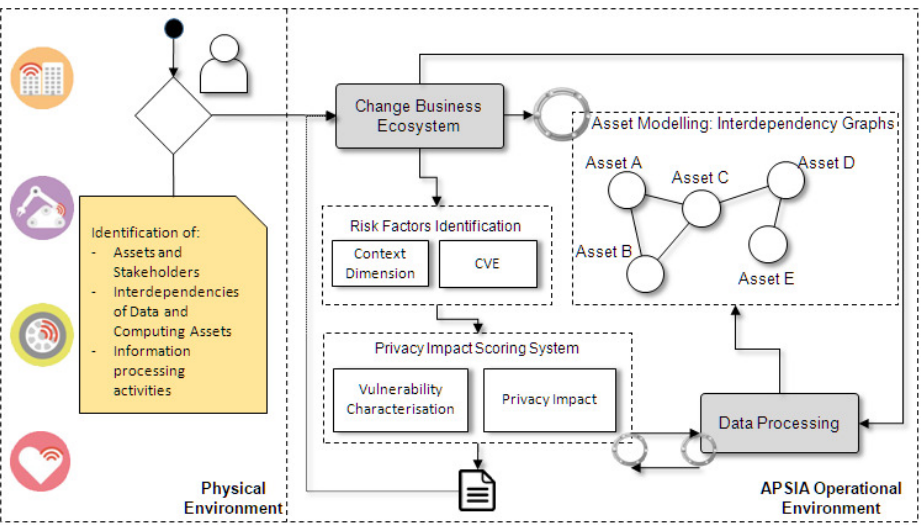
Figure 3. APSIA Conceptual